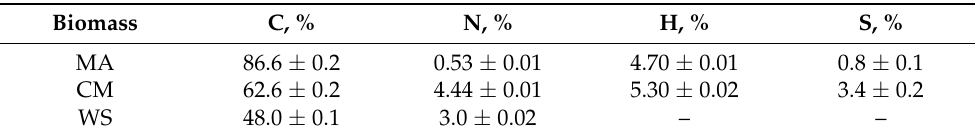
Table 2. Chemical parameters of MA and inoculum.